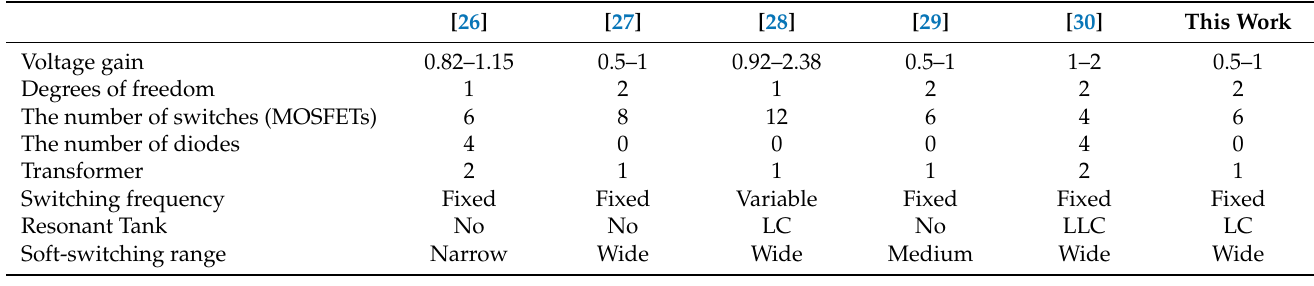
Table 4. Comparisions between the previous works.